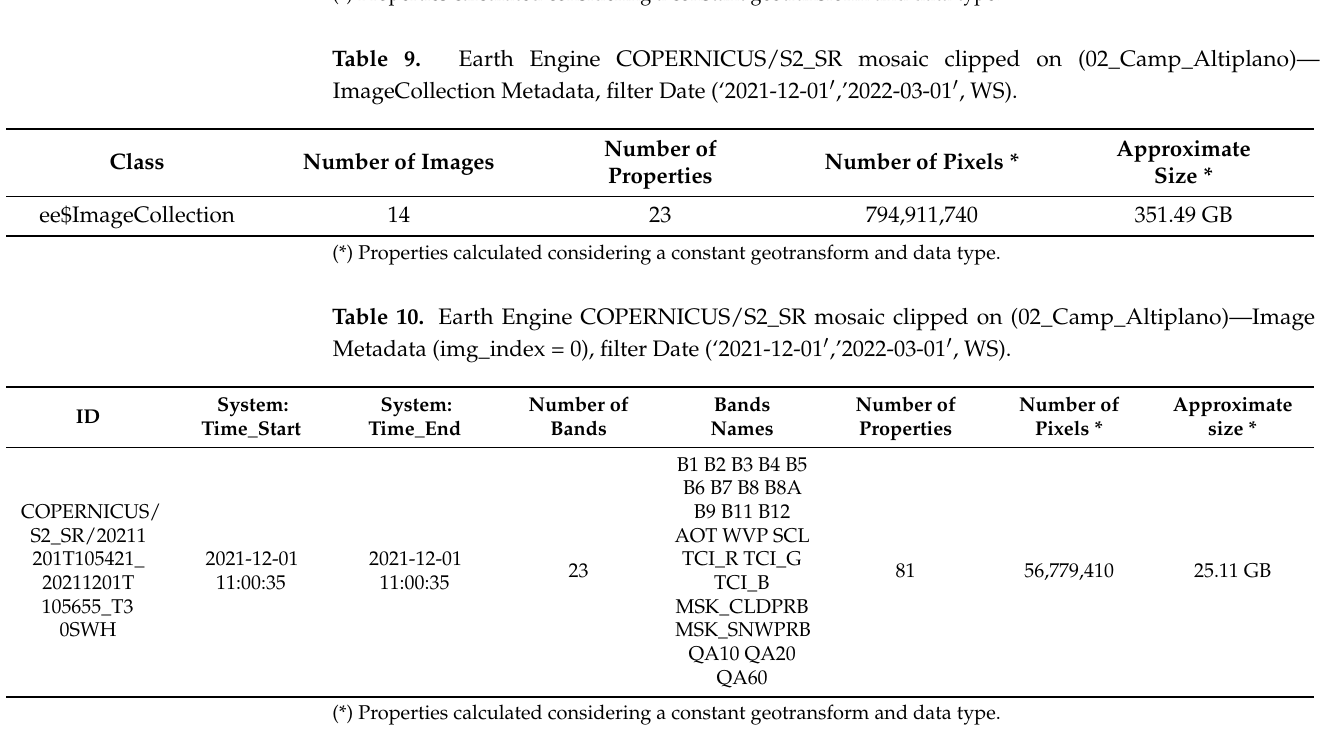
Table 11. Earth Engine COPERNICUS/S2_SR mosaic clipped on (02_Camp_Altiplano)–Band